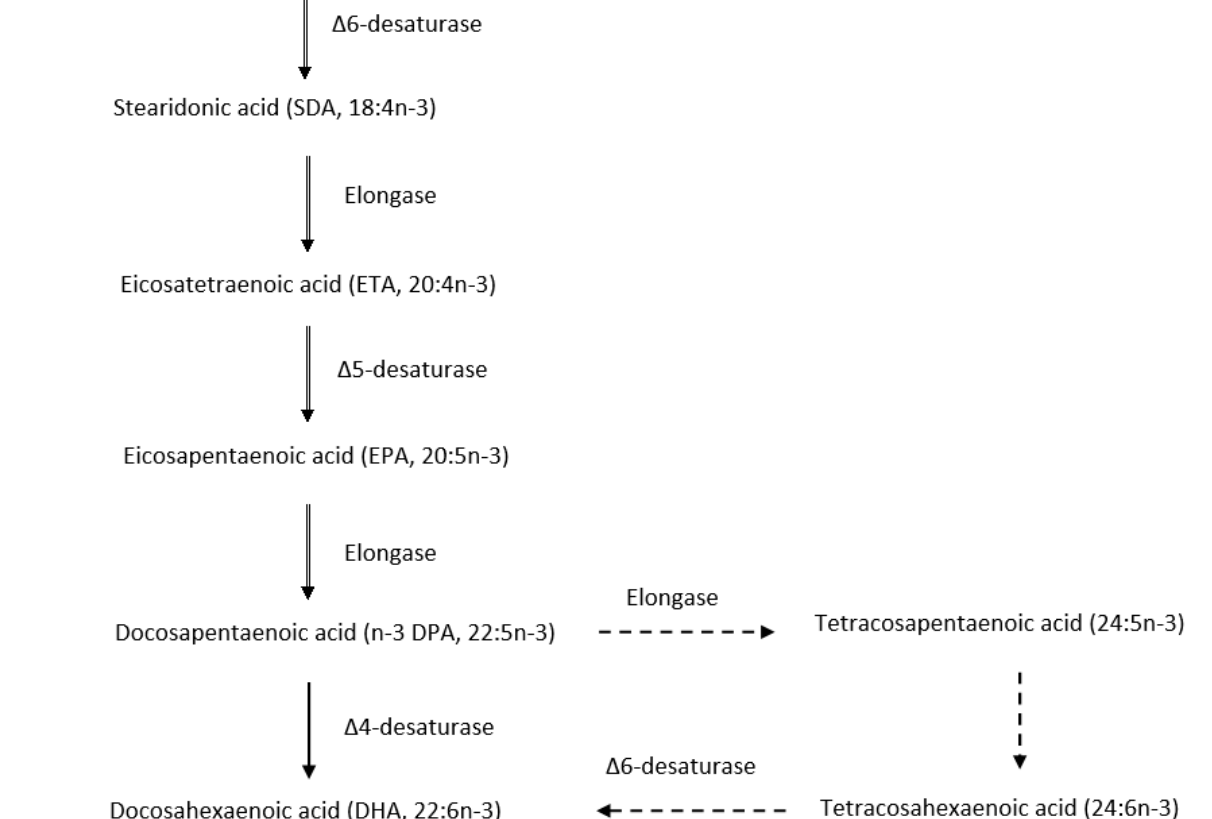
Figure 1. Possible biosynthesis and metabolic pathway of n-3 LC-PUFA. Thick arrows represent the conventional pathway; dotted lines with arrows represent presently accepted pathway (adapted from Park et al. [30] and Sprecher [29]).